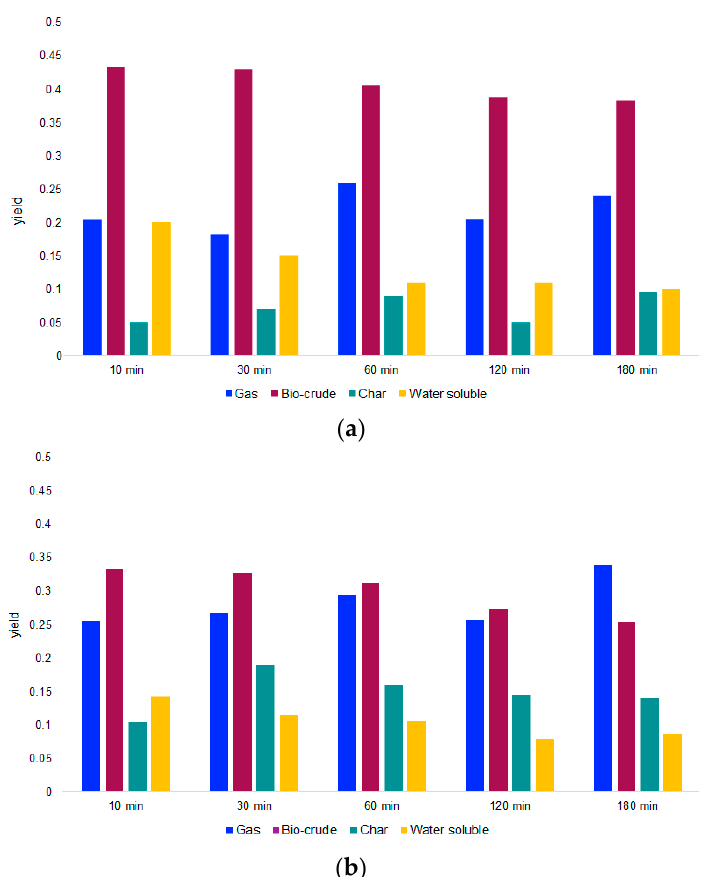
Figure 3. Effect of the reaction time on the product distribution with ( a ) BS and ( b ) BM at 330 °C.